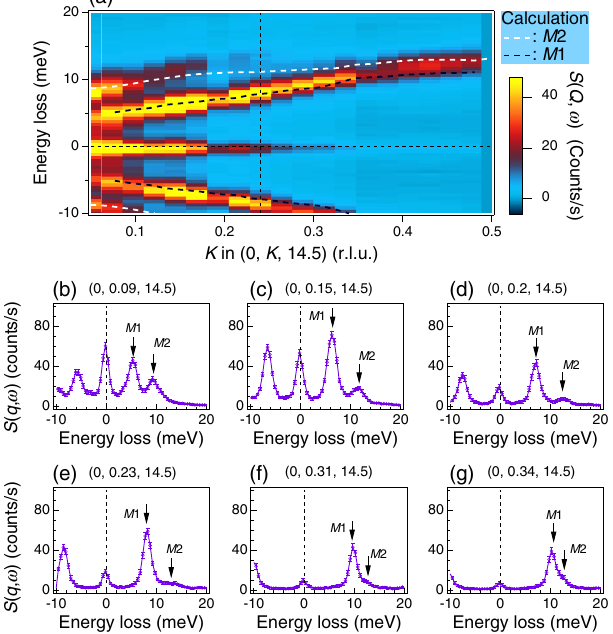
FIG. 1. Room-temperature phonon dynamic structure factor S ð Q ; ω Þ of La 1 Ba 0 CuO 4 . (a) Color map around . 875 . 125 ð 0 ; K; 14 . 5 Þ for K ¼ 0 → 0 . 5 r.l.u., showing two modes labeled M 1 and M 2 that match theoretical predictions shown as dashed lines. (b) – (g) Representative IXS spectra at K ¼ 0 . 09 , 0.15, 0.2, 0.23, 0.31, and 0.34 r.l.u., respectively. Panels (a) – (c) show spectra at K ¼ 0 . 09 , 0.23, and 0.31 r.l.u., respectively. A strong softening of M2 with decreas- ing temperature is seen at Q , which is reduced or absent CDW at other Q .